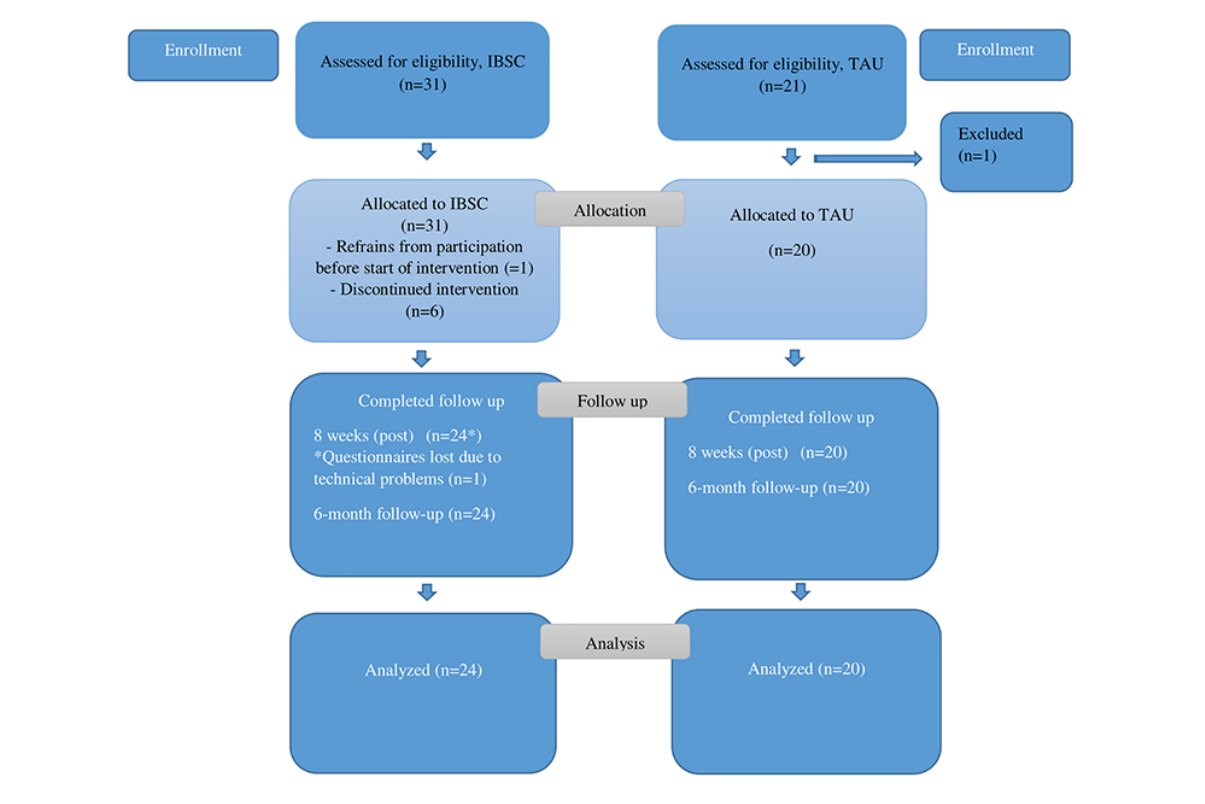
Figure 1. CONSORT (Consolidated Standards of Reporting Trials) flowchart of participants. Regarding TAU, after assessment for eligibility, one individual was excluded due to major depression, leaving 20 to be allocated to TAU. IBSC: internet-based support and coaching; TAU: treatment as